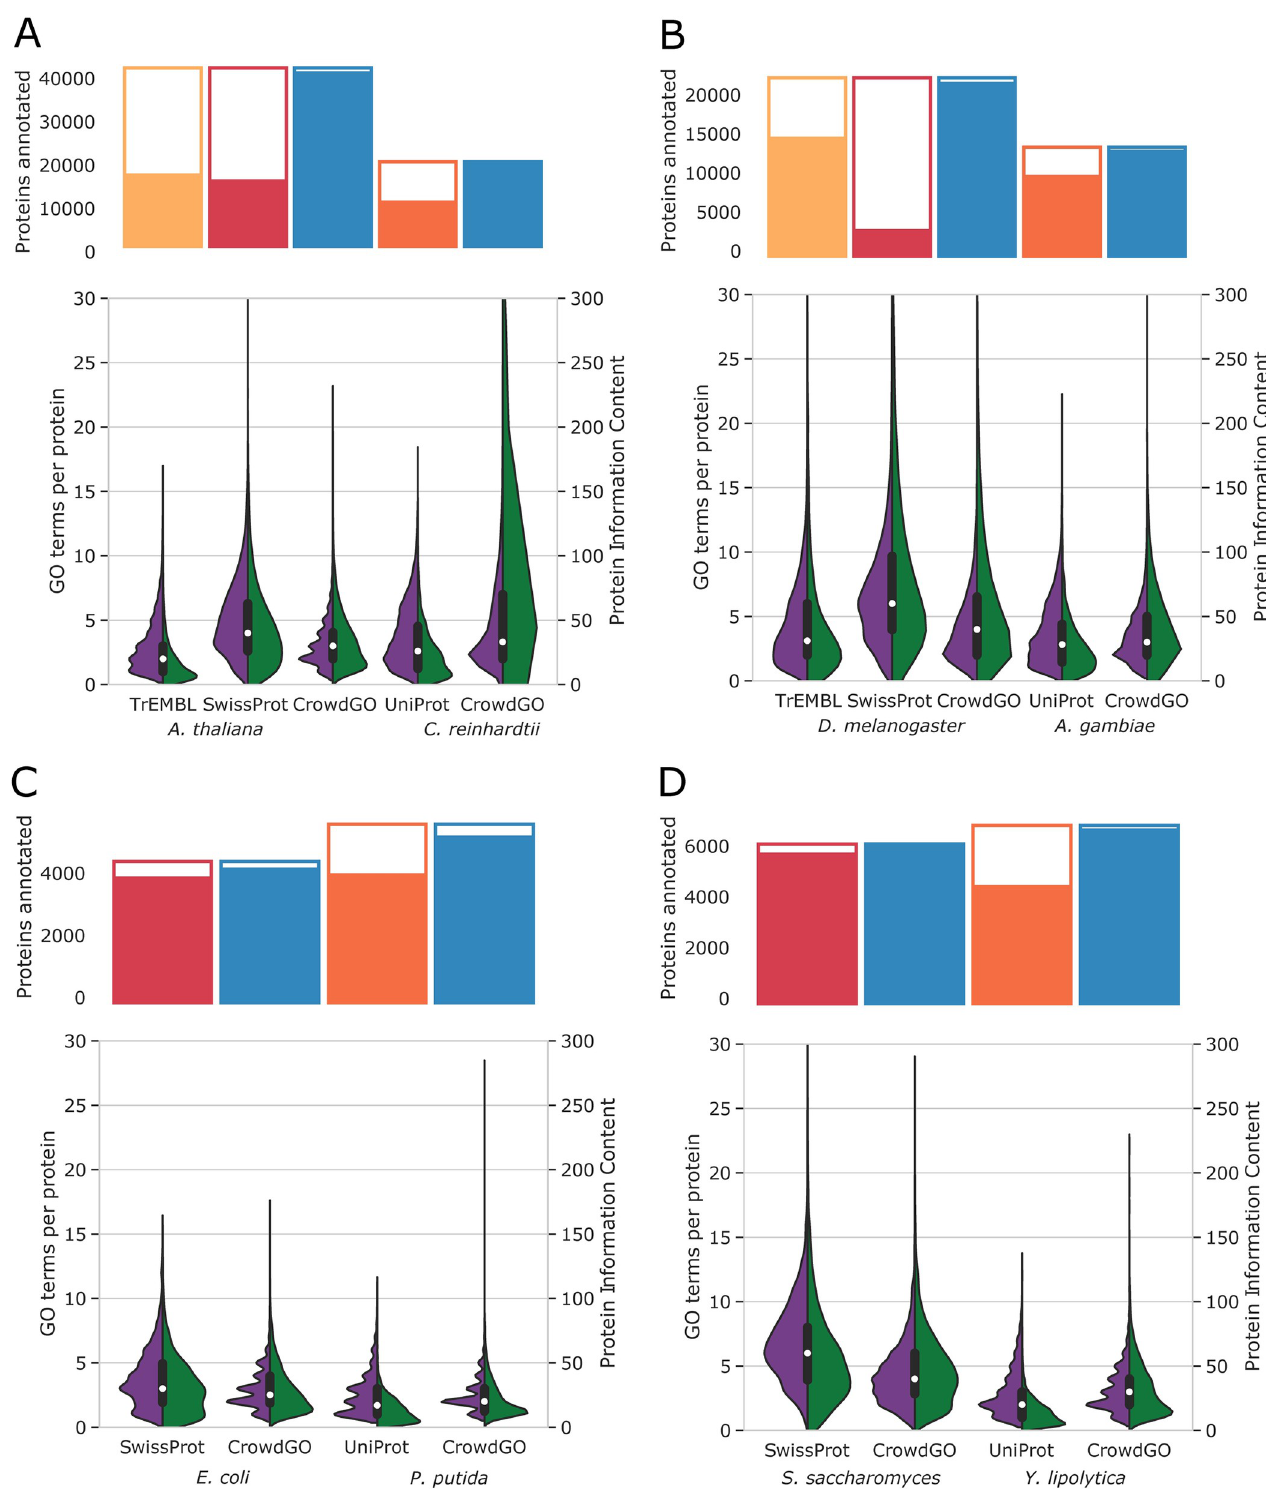
Fig 3. Comparisons of whole-proteome CrowdGO annotations and existing UniProt annotations. CrowdGO consensus annotation results (using the CrowdGOFull model) were compared with existing Gene Ontology (GO) term annotations from UniProt, and with the subsets of manually curated SwissProt (where available) and automatically inferred TrEMBL annotations, for representative taxa of (A) plants and algae, (B) insects, (C) bacteria, and (D) fungi. For each species traditionally considered as a model species ( A . thaliana , D . melanogaster , E . coli , and S . cerevisiae ) a non-model species is used for comparison ( C .